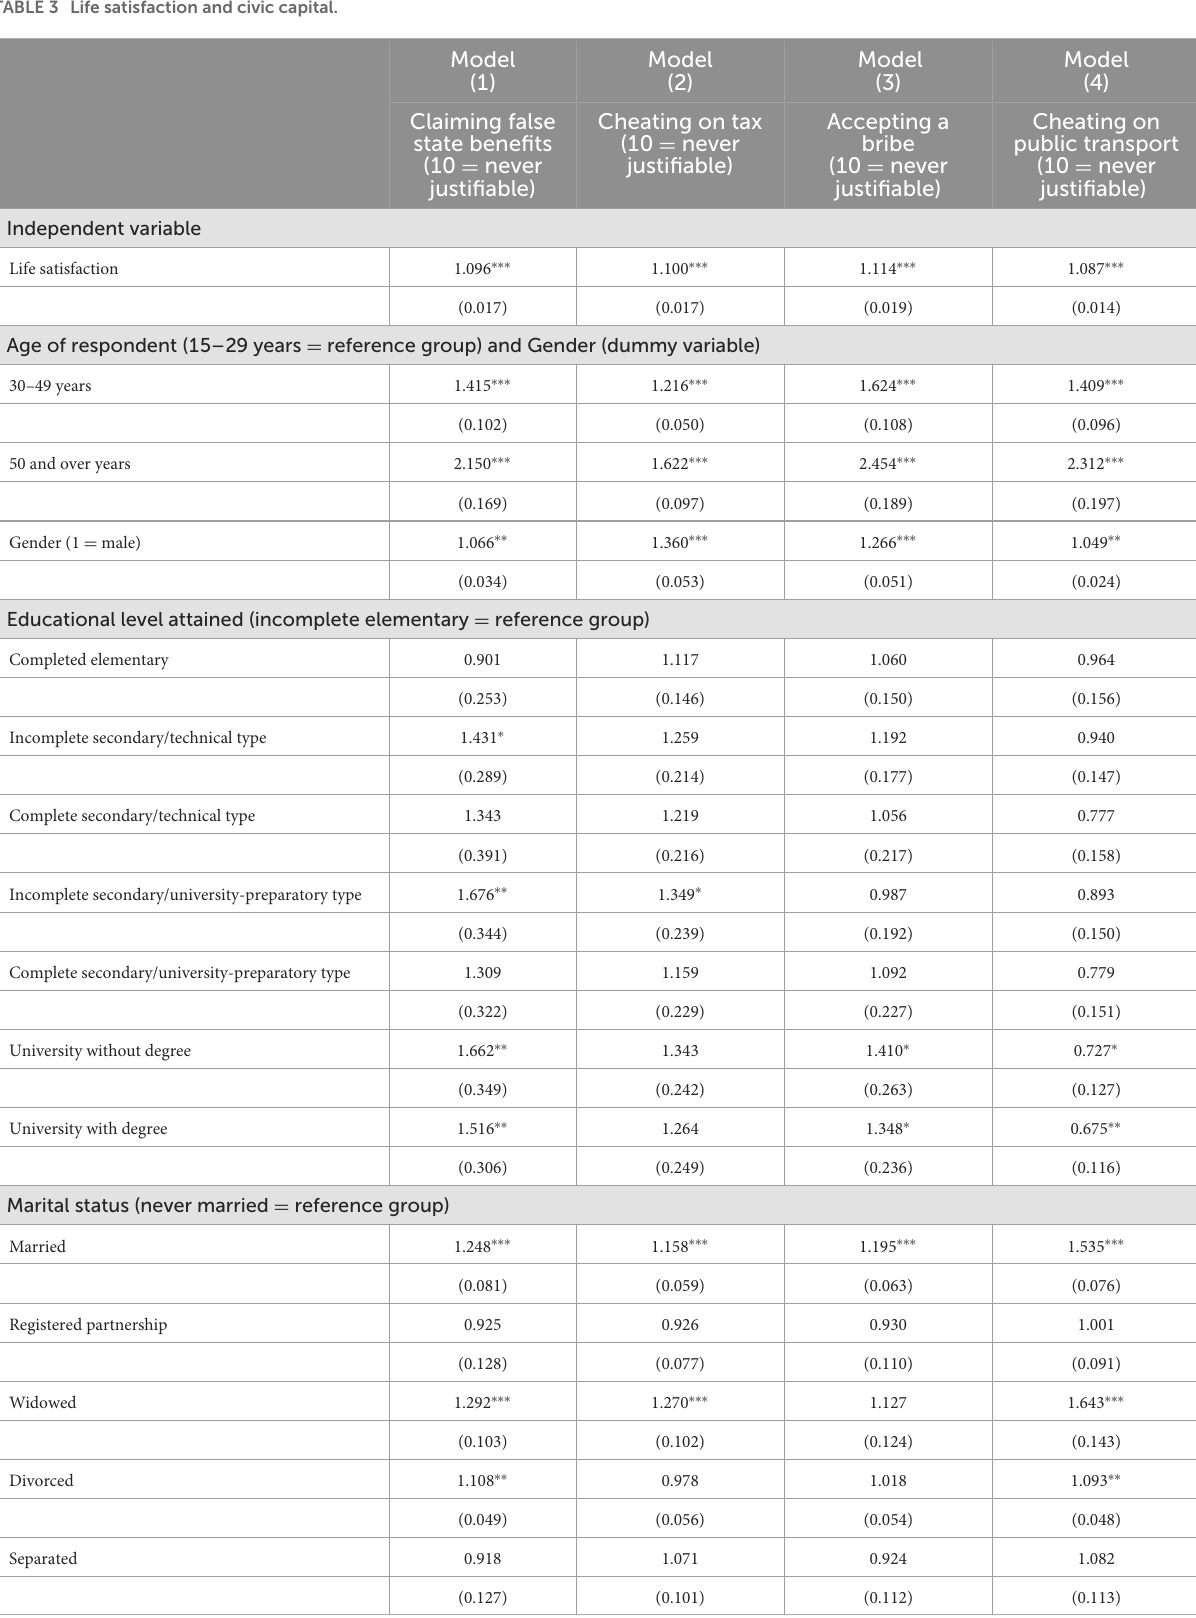
TABLE 3 Life satisfaction and civic